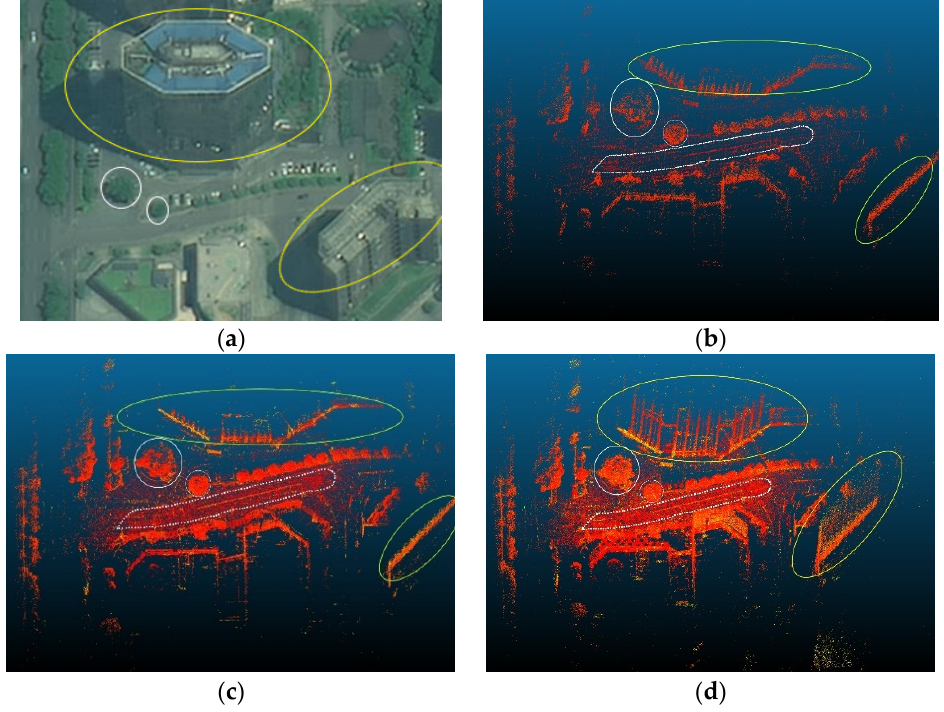
Figure 15. ( a ) City street scene, with the marks in the white circle representing trees and the marks in the yellow circle representing the building structure. ( b ) The mapping results of LeGO-LOAM in the city street scene provide a lack of building height information and the structure of buildings and trees is blurred. ( c ) The mapping results of LIO-SAM in the city street scene provide a lack of building height information, though the mapping of trees is relatively clear. ( d ) The mapping results of HSDLIO in the city street scene show that the point cloud features of the trees and the building structure are finer and more complete, including finer structural details.